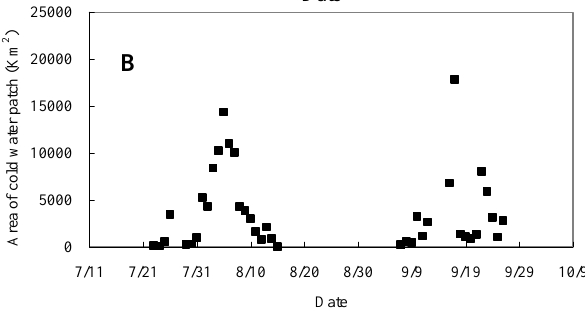
(Fig. 3d) during non-typhoon (in June and August 2007) and typhoon periods (August 2008) were used to demonstrate the vertical mixing vs. upwelling process in the study area. A typical T - S - σ θ diagram is shown in Fig. 3d. The red curve shows source water of the Kuroshio subsurface upwelling in the SECS. During a non-typhoon period, weak upwelling re- sulting from subsurface water of the Kuroshio was